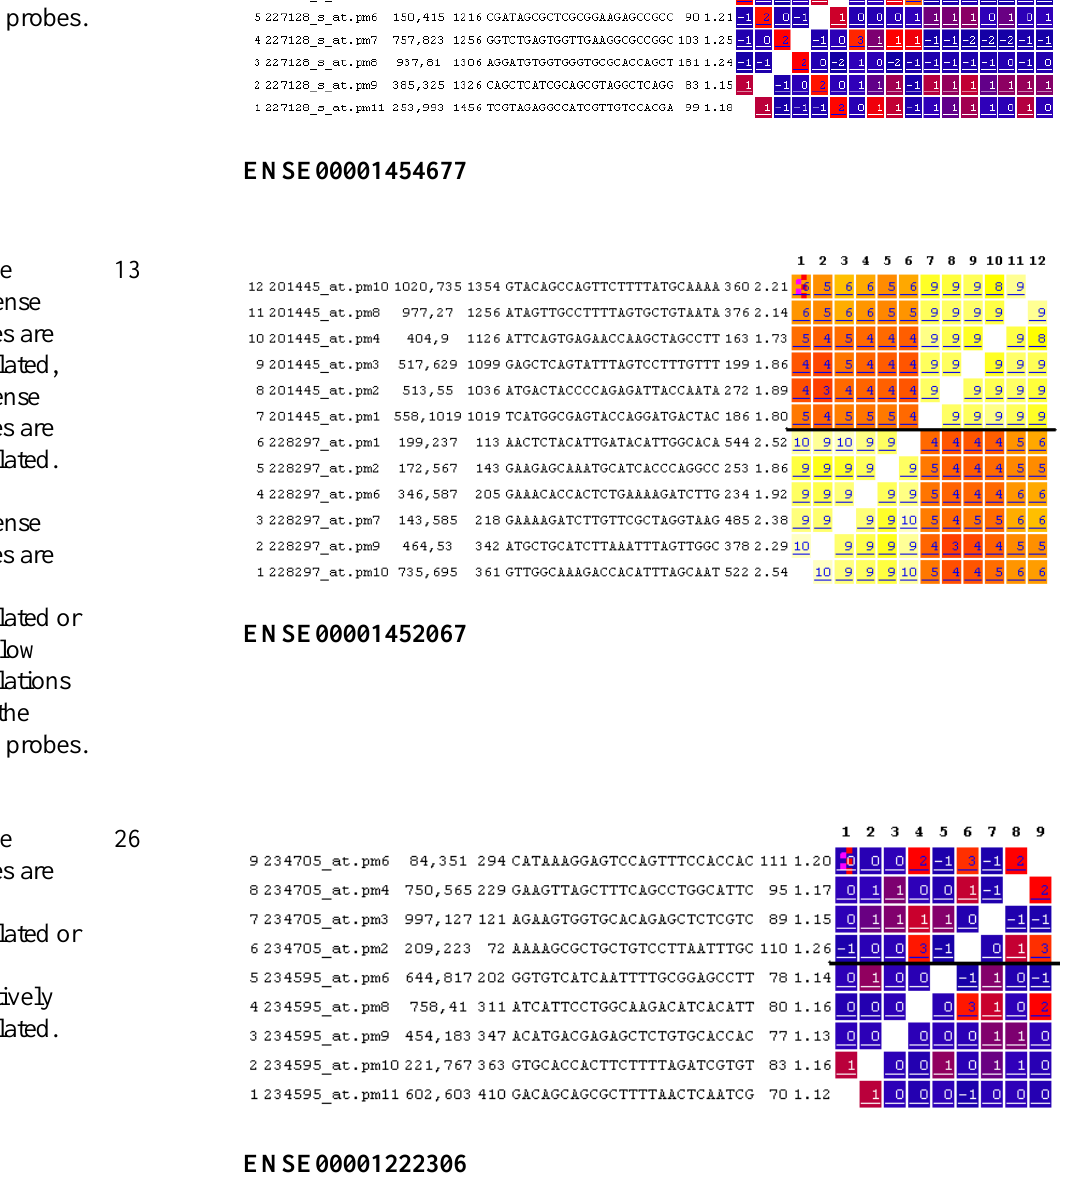
sense probes are correlated. A sub-group of sense probes may not be correlated with another sub-group of sense probes.